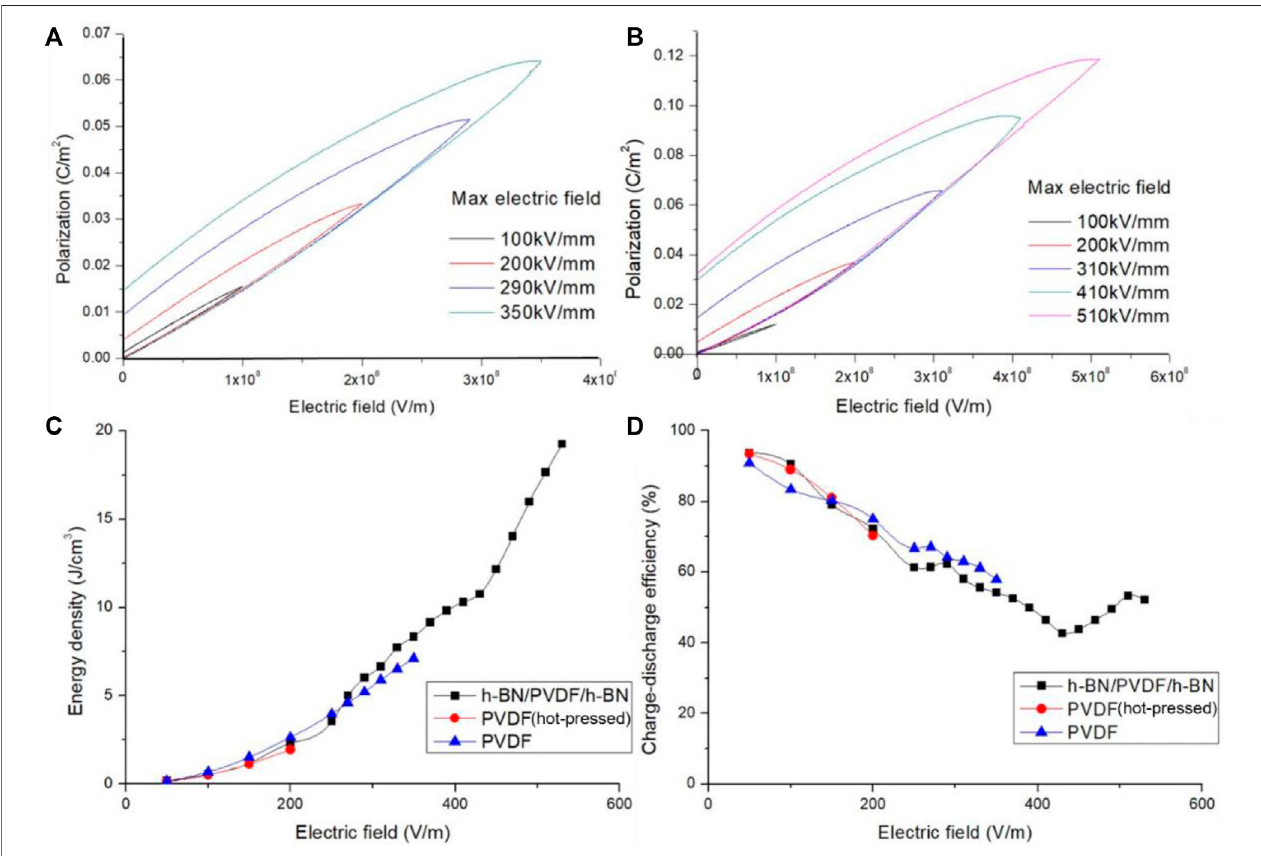
FIGURE 5 | Polarization electric fi eld (P – E) hysteresis of PVDF (A) and h-BN/PVDF/h-BN sandwiched-structure (B) . Discharged energy density of h-BN/PVDF/ h-BN, hot-pressed PVDF, and pristine PVDF fi lms (C) . Charge – discharge ef fi ciency of h-BN/PVDF/h-BN, hot-pressed PVDF, and pristine PVDF fi lms (D) .